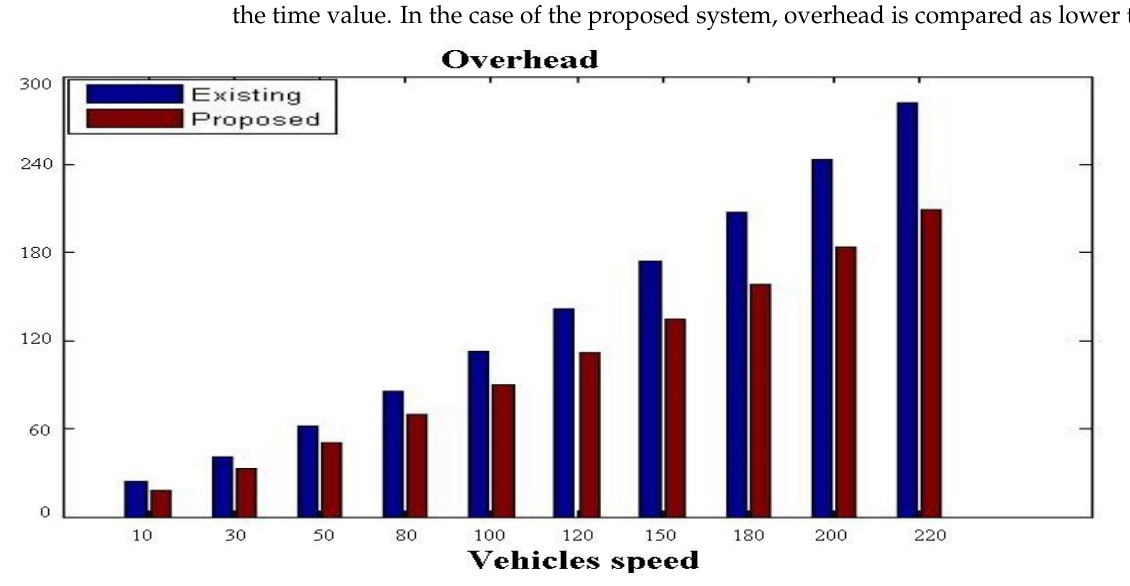
Figure 6. Overhead (seconds).